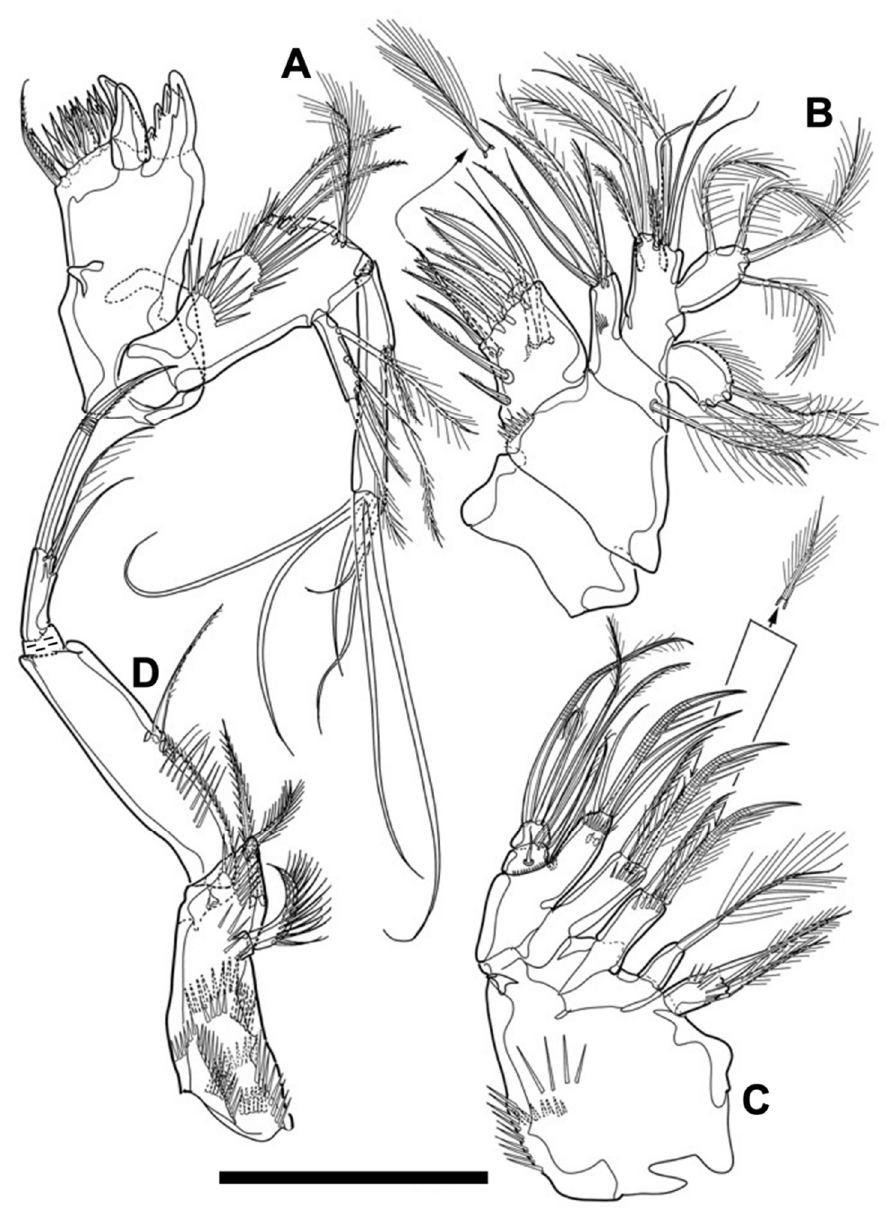
Figure 11. Line drawings of Phyllopodopsyllus saywakimi sp. nov. female (holotype): ( A ) mandible, anterior; ( B ) maxillule, posterior; ( C ) maxilla, anterior; ( D ) maxilliped, anterior. Scale bar: 50 µm. P1 (Figure 12A). Coxa about 0.9 times as long as greatest width and tapering distally. Basis shorter (about 0.6 times) and narrower (about 0.6 times) than coxa, and with two pedestals bearing inner and outer spine, respectively; inner pedestal ornamented with patch of long and short spinules; inner spine robust, bipinnate, and about as long as basis; outer spine shorter and finer than inner spine; distal margin bearing endopod furnished transversely with row of minute spinules. Endopod prehensile and longer than protopod (about 1.6 times) and exopod (about 1.5 times); first segment elongated, about seven times as long as wide, furnished with spinules along outer margin and setules from inner